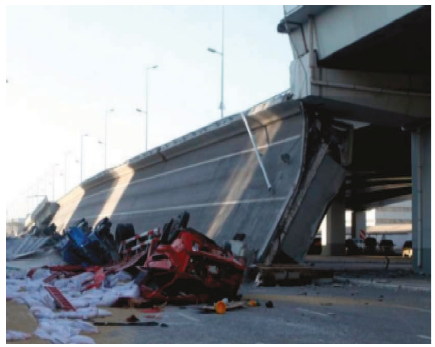
Figure 1: Collapse of the YangMingTan bridge.